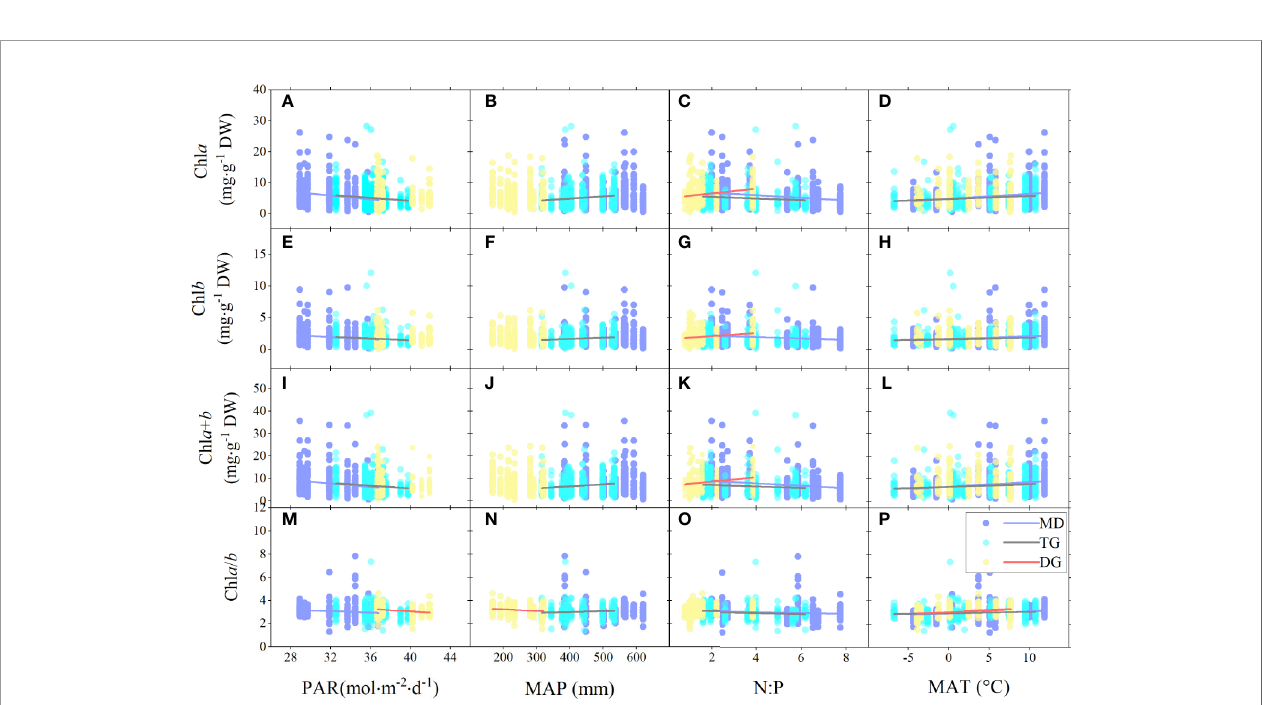
FIGURE 5 | Linear regressions of chlorophyll concentrations (chl a , chl b , and chl a + b ) and ratio (chl a / b ) with major environmental factors grouped by grassland types. (A – D) , (E – H) , (I – L) , and (M – P) denote regressions of chla, chlb, chla+b, and chla/b to four environmental factors, respectively. MD, meadow; TG, typical grassland; DG, desert grassland; PAR, photosynthetic active radiation; MAP, mean annual precipitation; N:P, ratio of soil nitrogen to soil phosphorus; MAT, mean annual temperature. Lines denote signi fi cant linear fi tted relationships ( p <